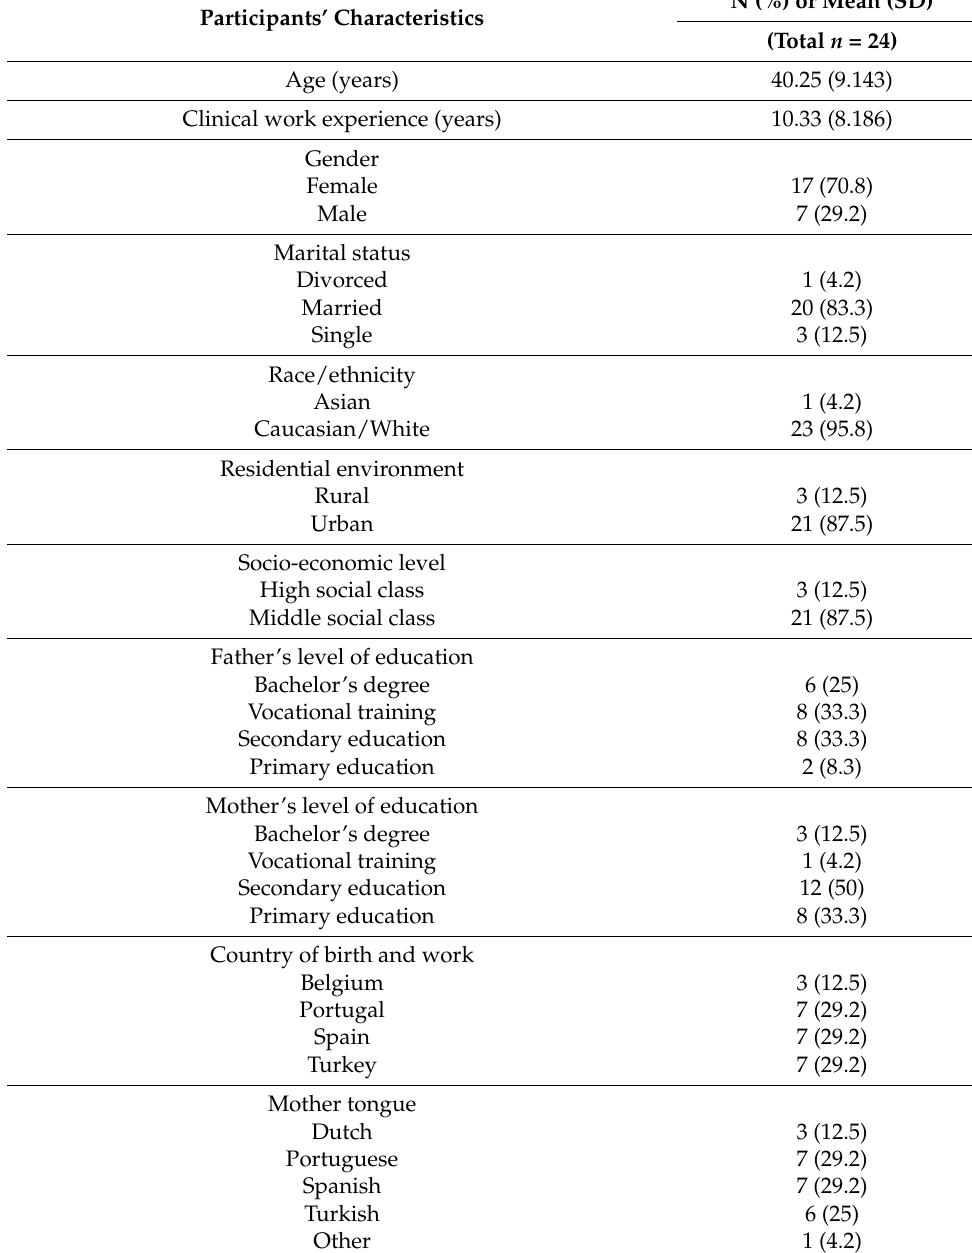
Table 3. Sociodemographic and cultural characteristics of the sample ( n =